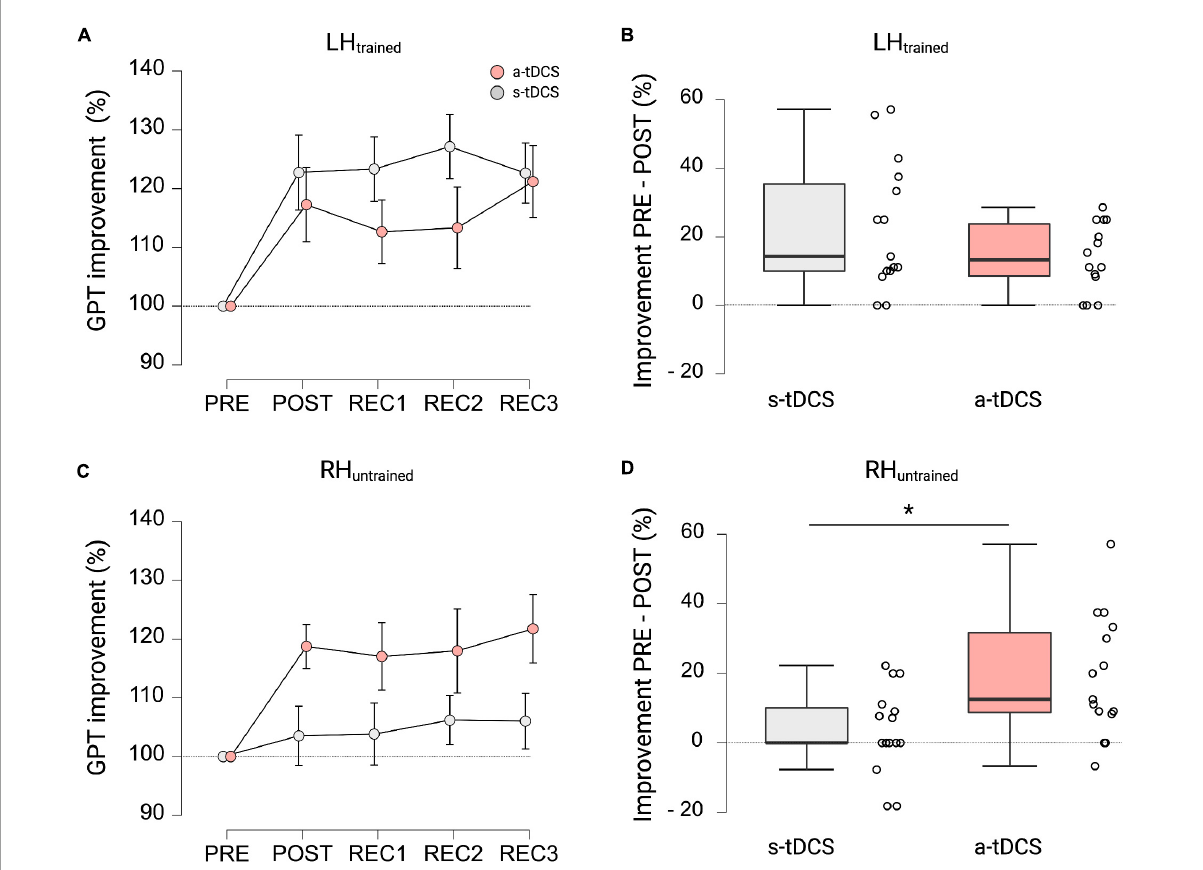
FIGURE3 GPT performance during recovery trials and cross-limb transfer for both groups. (A) Motor performance of LH trained . Displayed are mean ± 95% confidence intervals. All values are normalized to values obtained at PRE, representing percentage improvements. (B) Percentage improvements in GPT of LH trained from PRE to POST between a-tDCS and s-tDCS. No significant difference in motor performance was observed between groups. (C) Cross-limb transfer of RH untrained . Displayed are mean ± 95% confidence intervals. All values are normalized to values obtained at PRE, representing percentage improvements. (D) Percentage improvements in GPT of RH untrained from PRE to POST between a-tDCS and s-tDCS. A-tDCS demonstrated significantly higher cross-limb transfer compared to s-tDCS. *Indicates a significant group